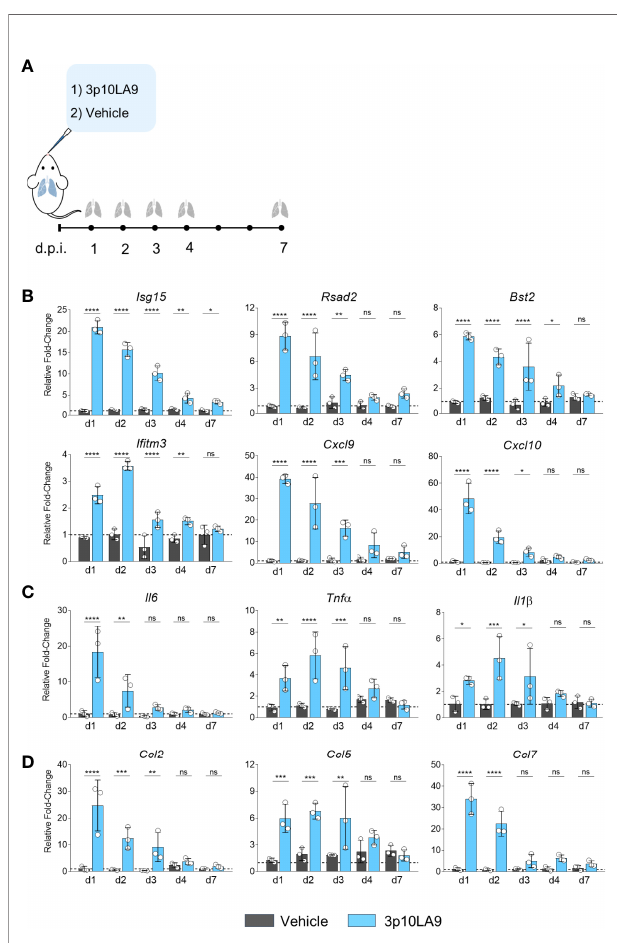
FIGURE 3 | Transient ISG and pro-in fl ammatory response induced by dsRNA hairpins. (A) Intranasal treatment protocol in C57BL/6J mice. (B-D) Relative fold change in gene expression of indicated ISGs, cytokines, and chemokines from lung homogenates at d0 (dotted line), d1, d2, d3, d4, and d7 were measured by qRT-PCR obtained from mice treated with 3p10LA9 (treated group, light blue) and vehicle alone (control group, grey). The error bars represent the SEM (n= 3 mice). * P <0.05; *** P <0.001;**** P <0.0001; ns, not signi fi cant; two-tailed t-Student ’ s